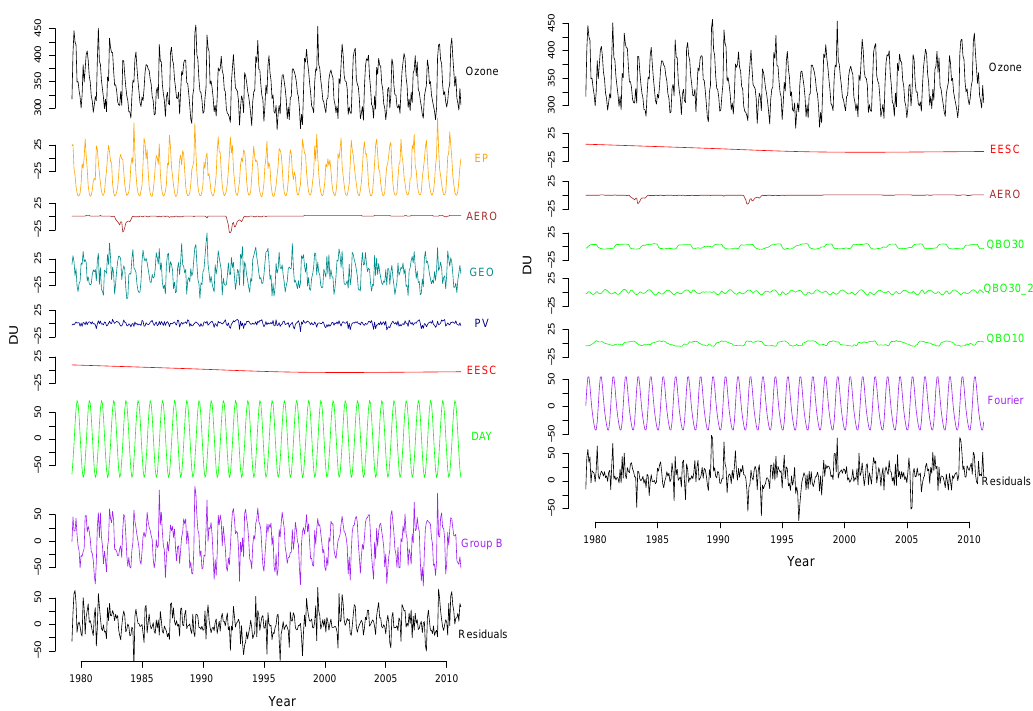
Figure 7. Results of the PHYS regression (left plot) and of the STAT regression (right plot) performed in Reykjavik, Iceland. “Fourier” is defined as the sum of the harmonic components that describe seasonal variation in ozone and the “group B” term is defined as the sum of EP, GEO, PV and DAY, describing the seasonal component according to the PHYS model. QBO10 and QBO30 represent the QBO index at 10 and at 30hPa, respectively.